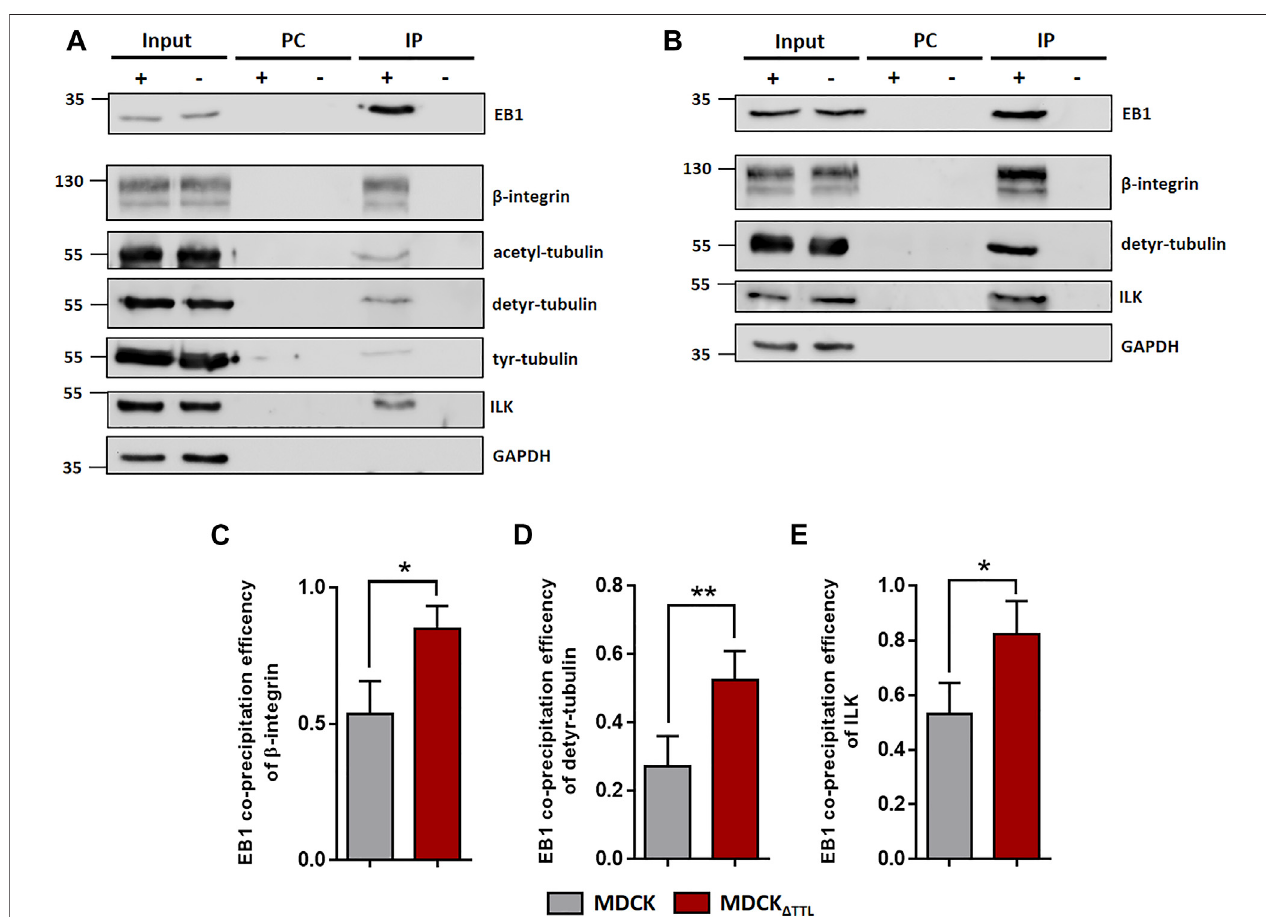
FIGURE5| EB1-pulldownfollowingTTL-modulation. (A) MDCKcelllysateswereincubatedwithanti-EB1antibodiesfollowedbyprecipitationwithagarosebeads. Precipitateswereanalyzedbyimmunoblot usingantibodiesdirectedagainst β 1-integrin(CD29),acetyl-,detyr- andtyr-tubulin, ILK,GAPDHand EB1. n =3independent experiments. PC, Pre-clearing using agarose beads; IP+, Immunoprecipitation using EB1 antibodies and agarose beads; IP-, Immunoprecipitation using unspeci fi c IgG antibodies and agarose beads. Representative results. (B) MDCK Δ TTL cell lysates were incubated with anti-EB1 antibodies followed by precipitation with agarose beads. Precipitates were analyzed by immunoblot using antibodies directed against β 1-integrin, detyr-tubulin, ILK, GAPDH and EB1. n = 3 independent experiments. PC, Pre-clearing using agarose beads; IP+, Immunoprecipitation using EB1 antibodies and agarose beads; IP-, Immunoprecipitation using unspeci fi c IgG antibodies and agarose beads. Representative results. (C – E) Quanti fi cation of MDCK and MDCK Δ TTL co-precipitation ef fi ciencies of β 1-integrin (C) , detyr-tubulin (D) and ILK (E) from three independent experiments. The ef fi ciencies were normalized by the total quantities of each polypeptide in the input. Mean ± s.d., n = 3. Statistical signi fi